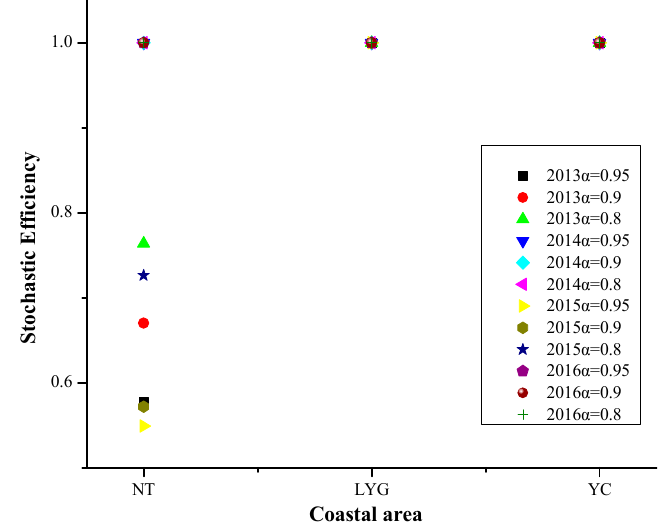
Figure 9. Stochastic efficiency values in coastal area at different risk levels in